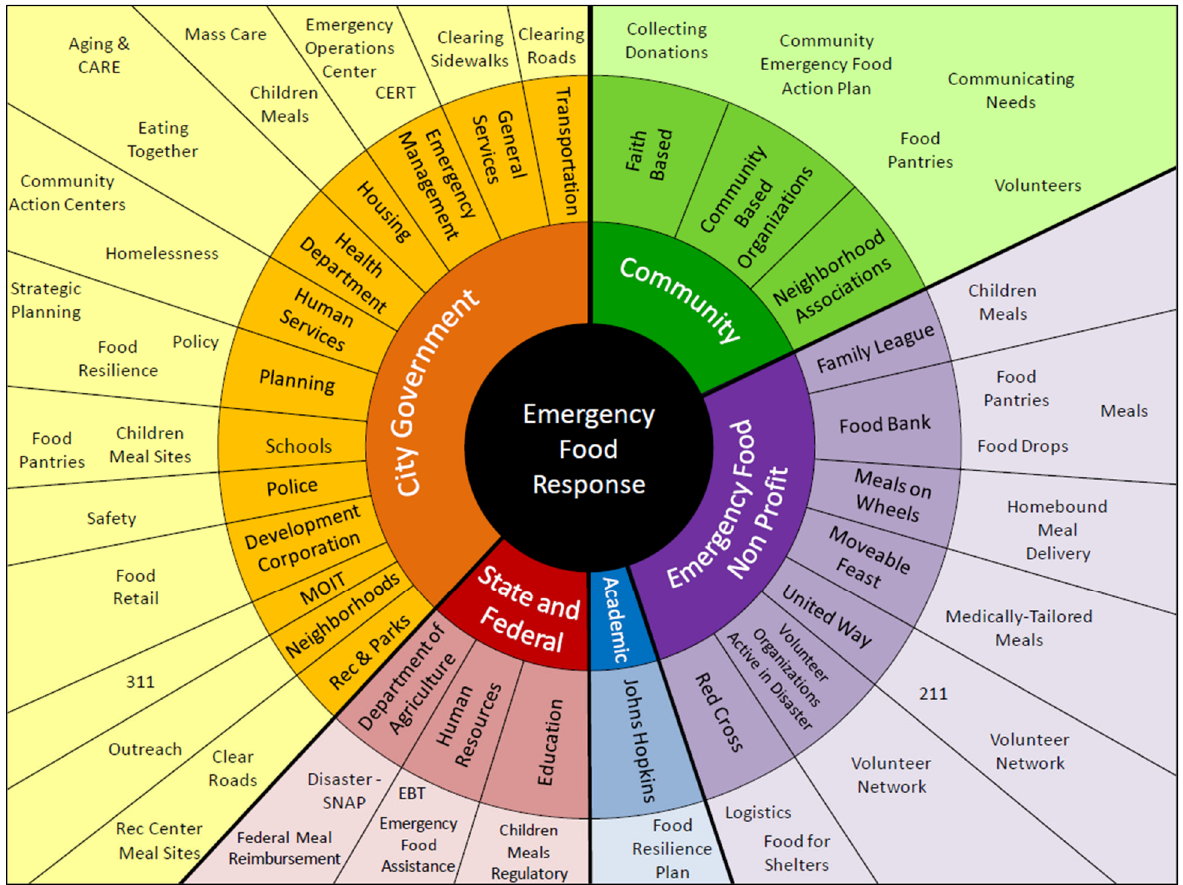
Figure 2. Baltimore’s Short-term Plan for Food Access During Incidents and Disasters Representatives of government, academia, community, and nonprofit sectors provided input on Baltimore’s short-term Plan for Food Access during incidents and disasters. The second ring shows organizations who provided input in the Plan for Food Access. The outer section depicts organizations’ responsibilities during and after a